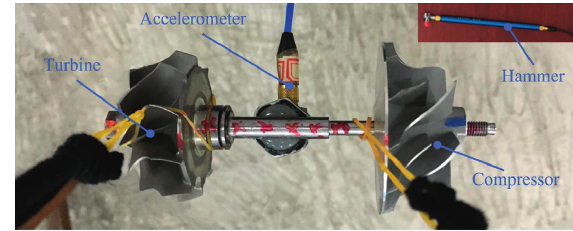
Figure 24: Hammering experiment for a